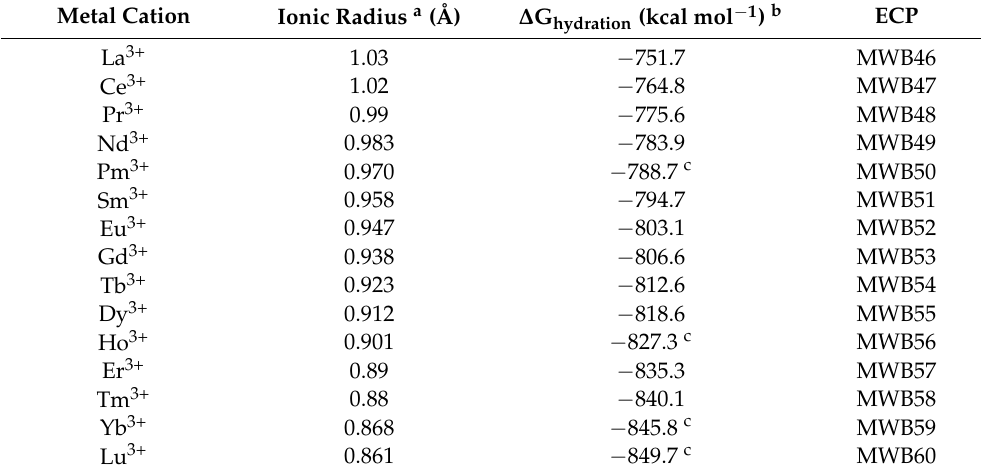
Table 4. Ionic radii, hydration free energies and effective core potentials for